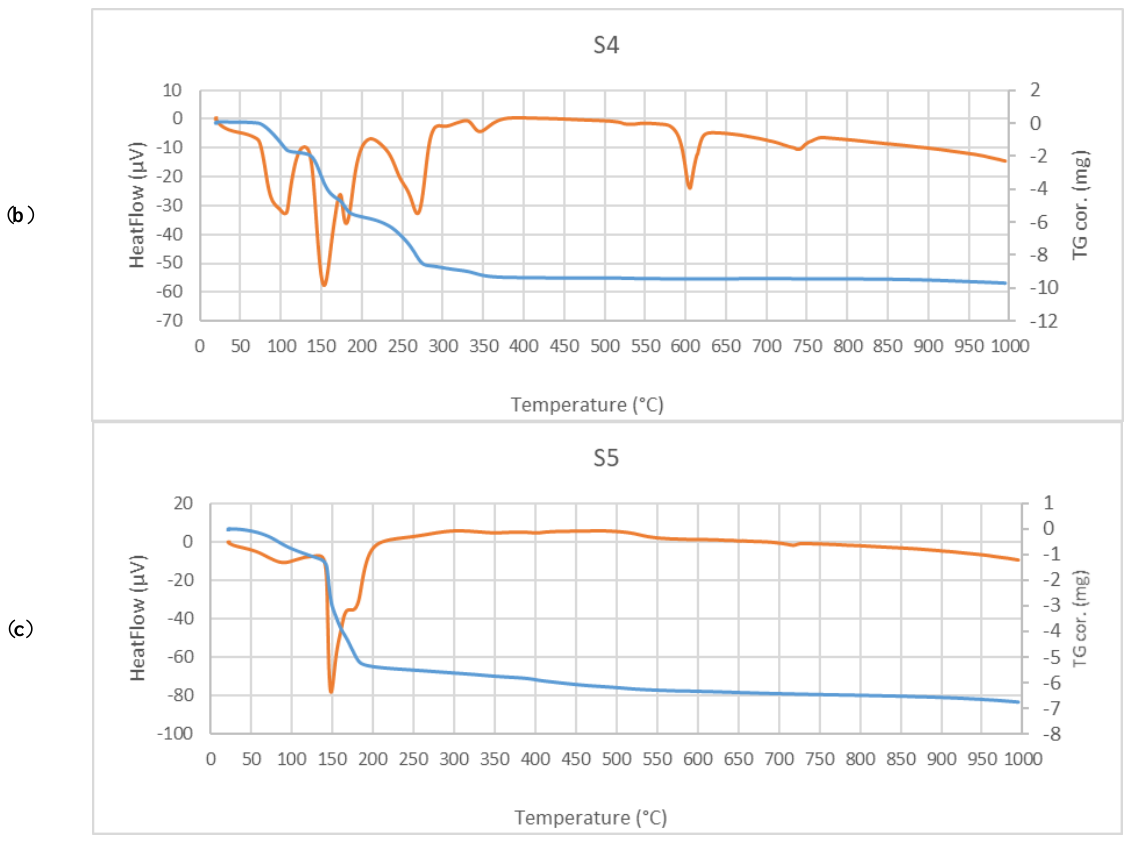
Figure 2. ( a – c ) Thermogravimetric data for samples S3 – S5. Table 1. Particle size distribution and mean particle size obtained from histograms.